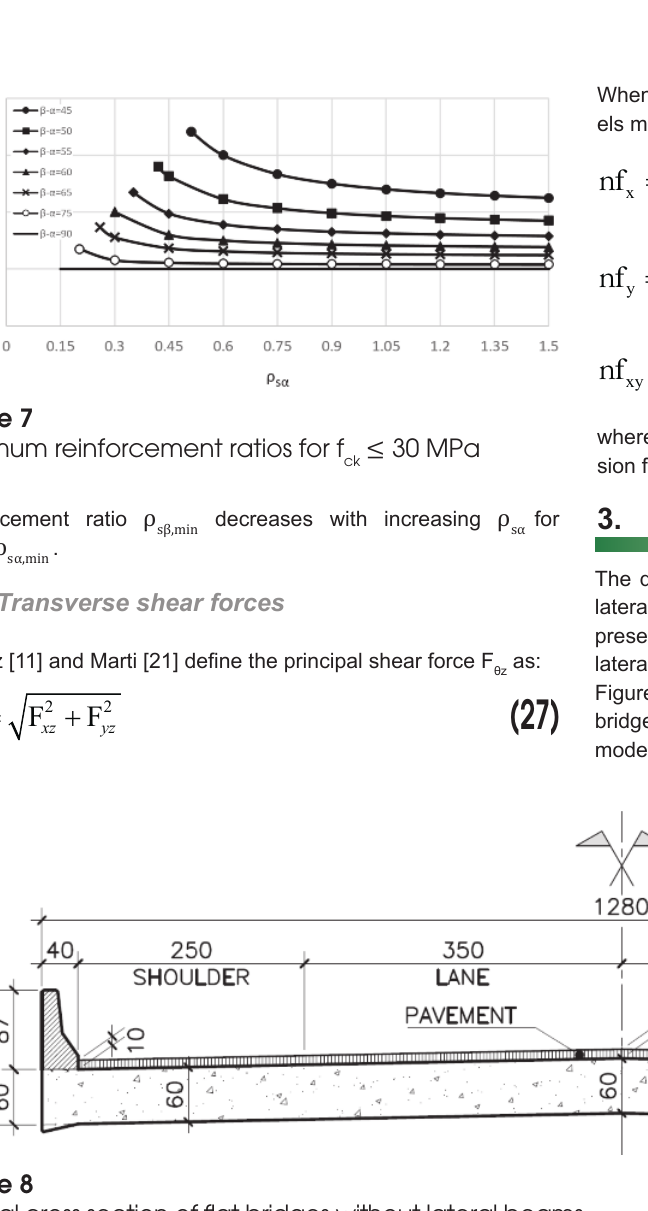
Typical cross section of flat bridges without lateral beams